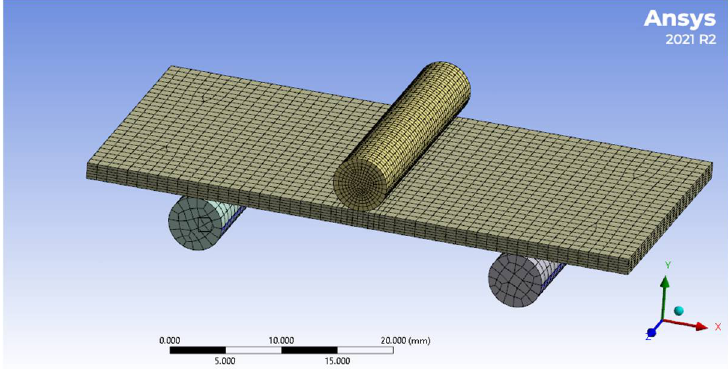
Figure 2. FEA mesh of coupon with rollers and loading nose .